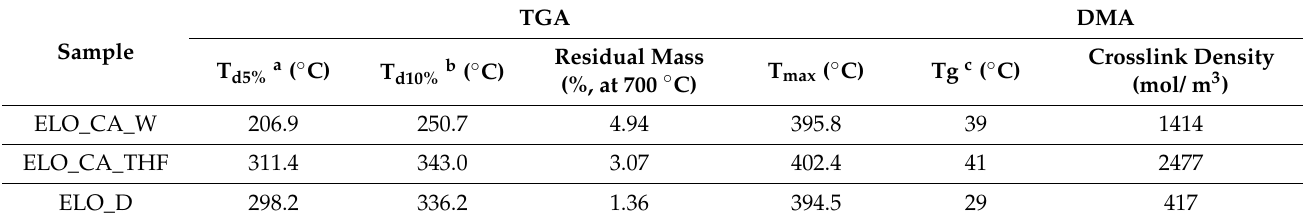
Table 3. TGA and DMA data for the ELO-based synthesized